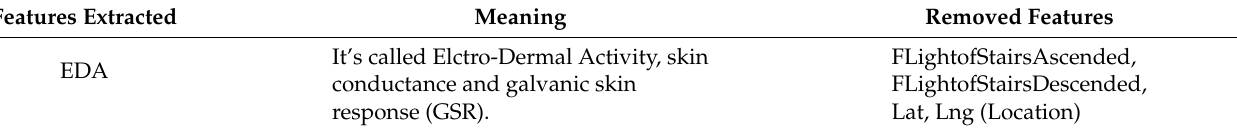
Table 5. Extracted and removed